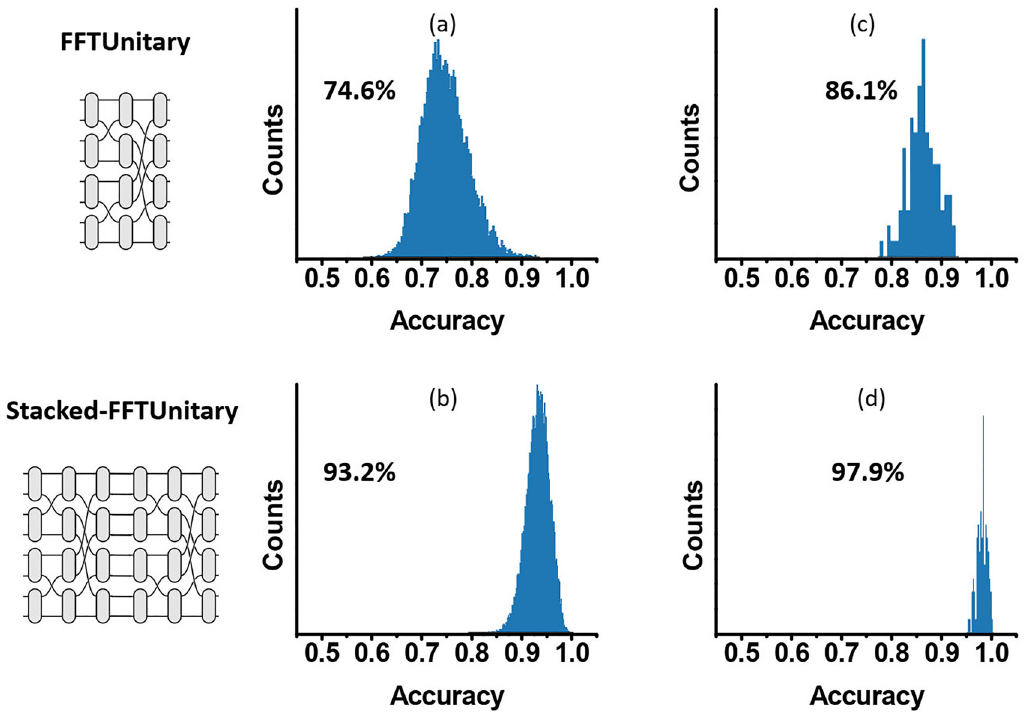
Figure 3: The statistical accuracy distribution of expressing 8*8 unitary matrix by (a) FFTUnitary mesh and (b) stacked-FFTUnitary mesh; the statistical accuracy distribution of expressing minimal-error one picked for real-value matrix based on pseudo-real-value (c) FFTUnitary mesh and (d)